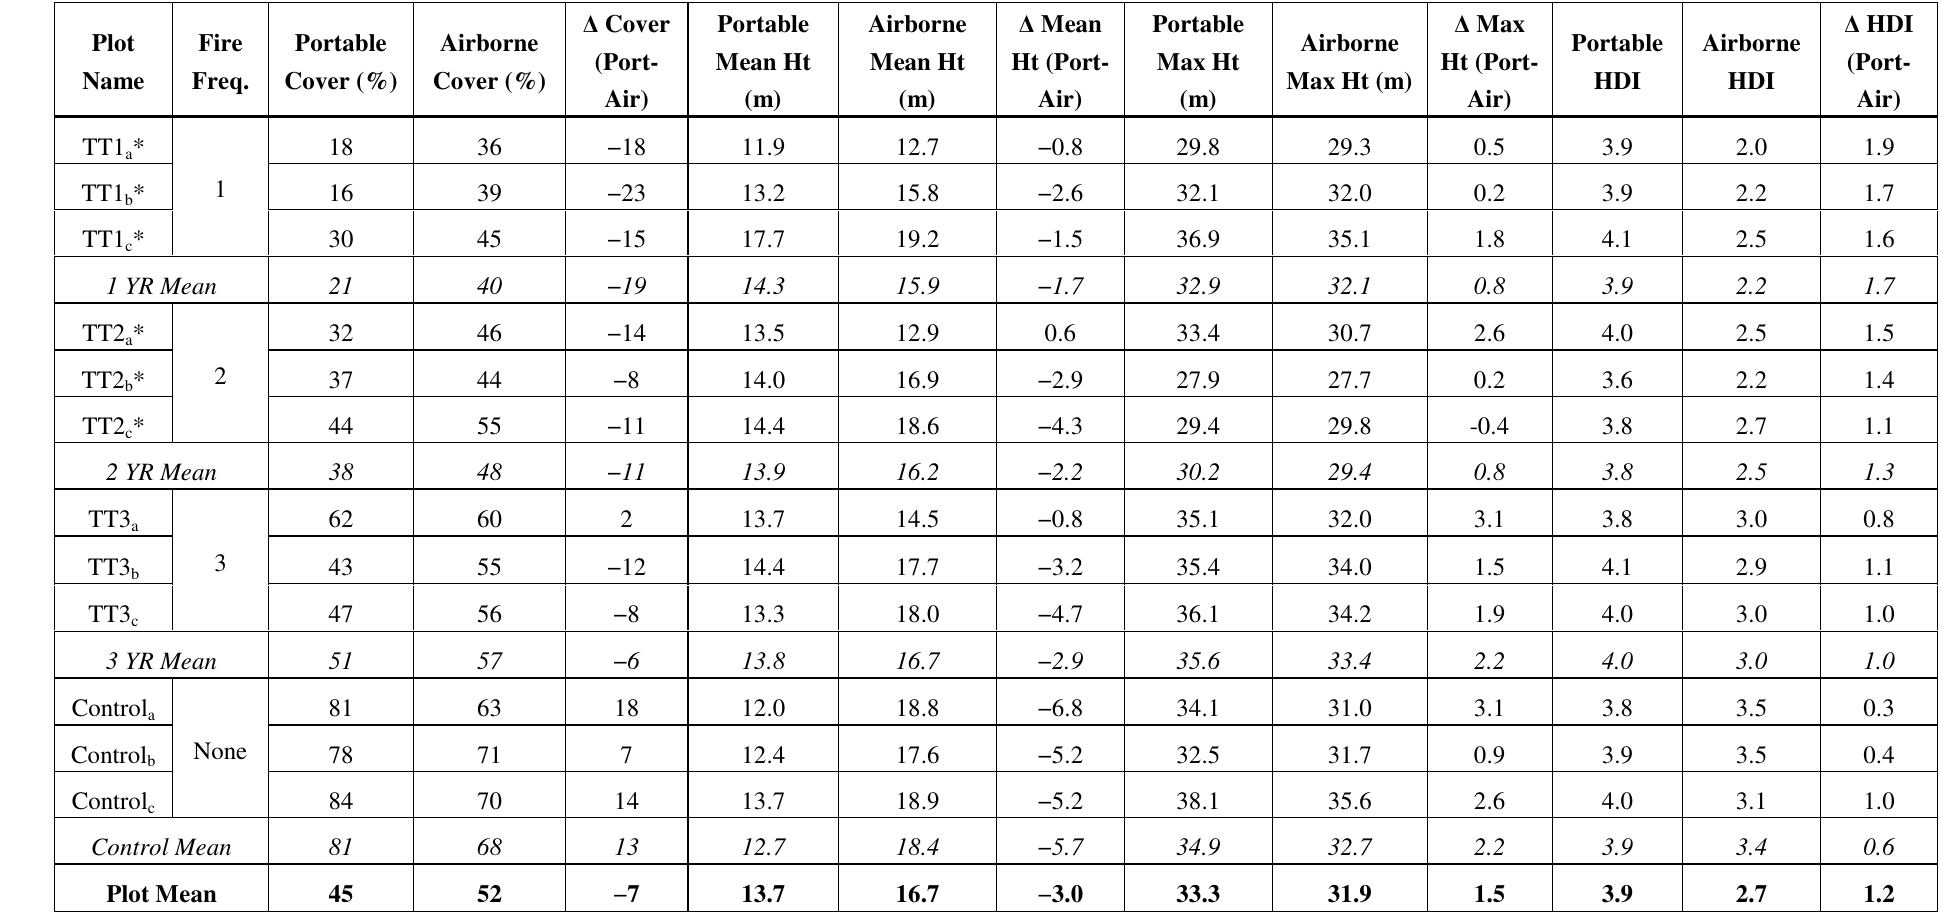
Table 1. Portable and Airborne LiDAR Metrics for the Stoddard Fire Plots at Tall Timbers Research Station.